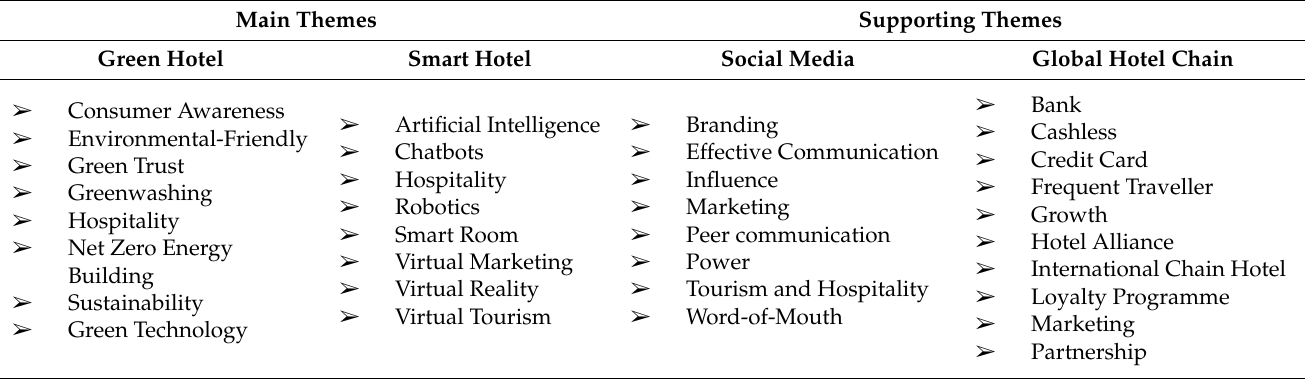
Table 1. Themes and